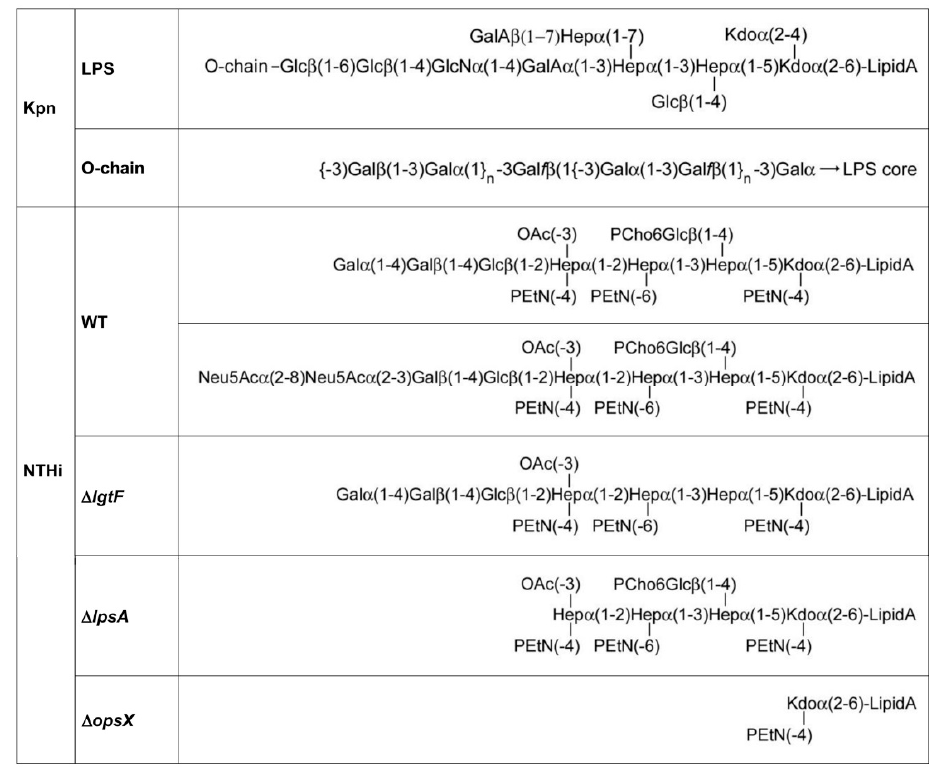
Figure 4. Structure of Kpn and NTHi LPS/LOSs. The structures shown correspond to K. pneumoniae 52145 and to NTHi 375 wild type and mutant strains. The two LOS glycoforms found for NTHi 375 [17] are shown. For the sake of simplicity, only the major, Gal-terminated glycoform is shown for the Δ lgtF mutant.